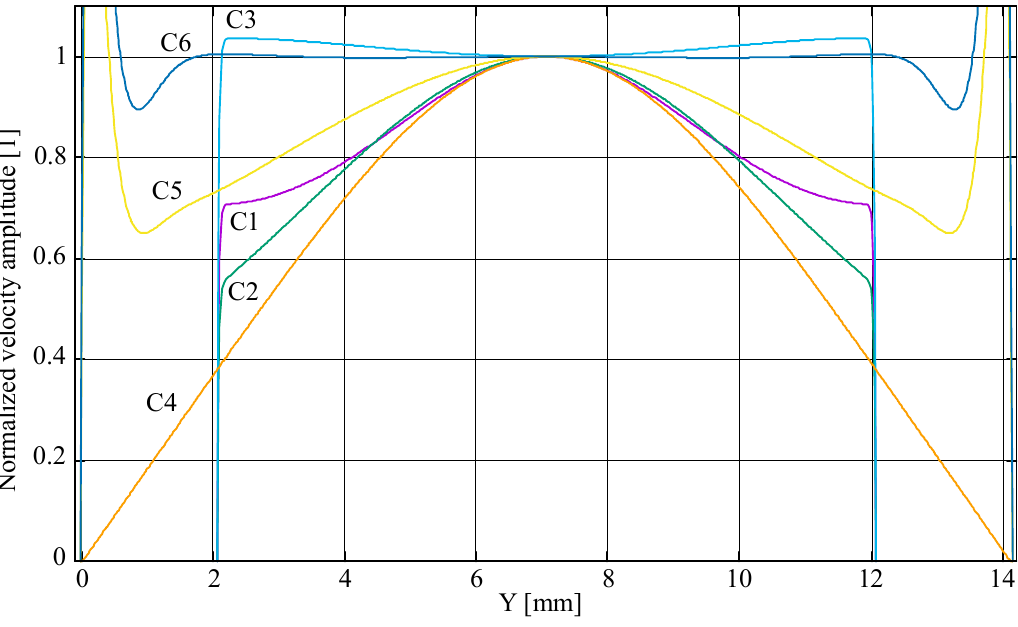
Figure 5. Numerical simulation of the profile of velocity across the middle of the chamber in the microfluidic interfaces of Figure 2 (the velocity is normalized to the velocity at the center of the chamber). C5 and C6 have large velocities at each side of the profile, because the cross-section in